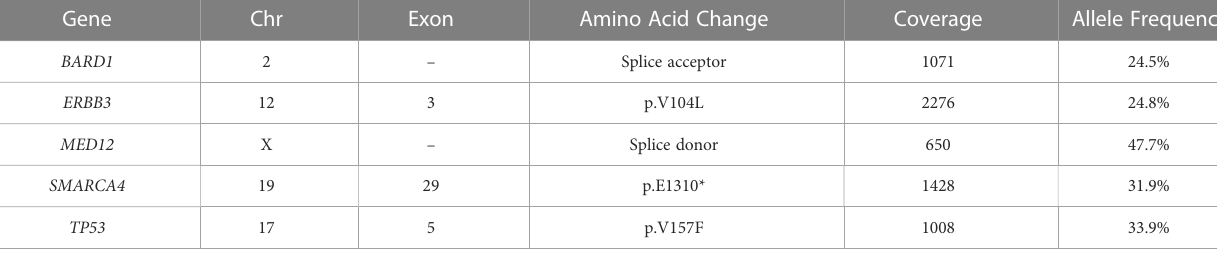
TABLE 1 Next-generation sequencing of detected gene mutations in the tumor biopsy specimen. Gene